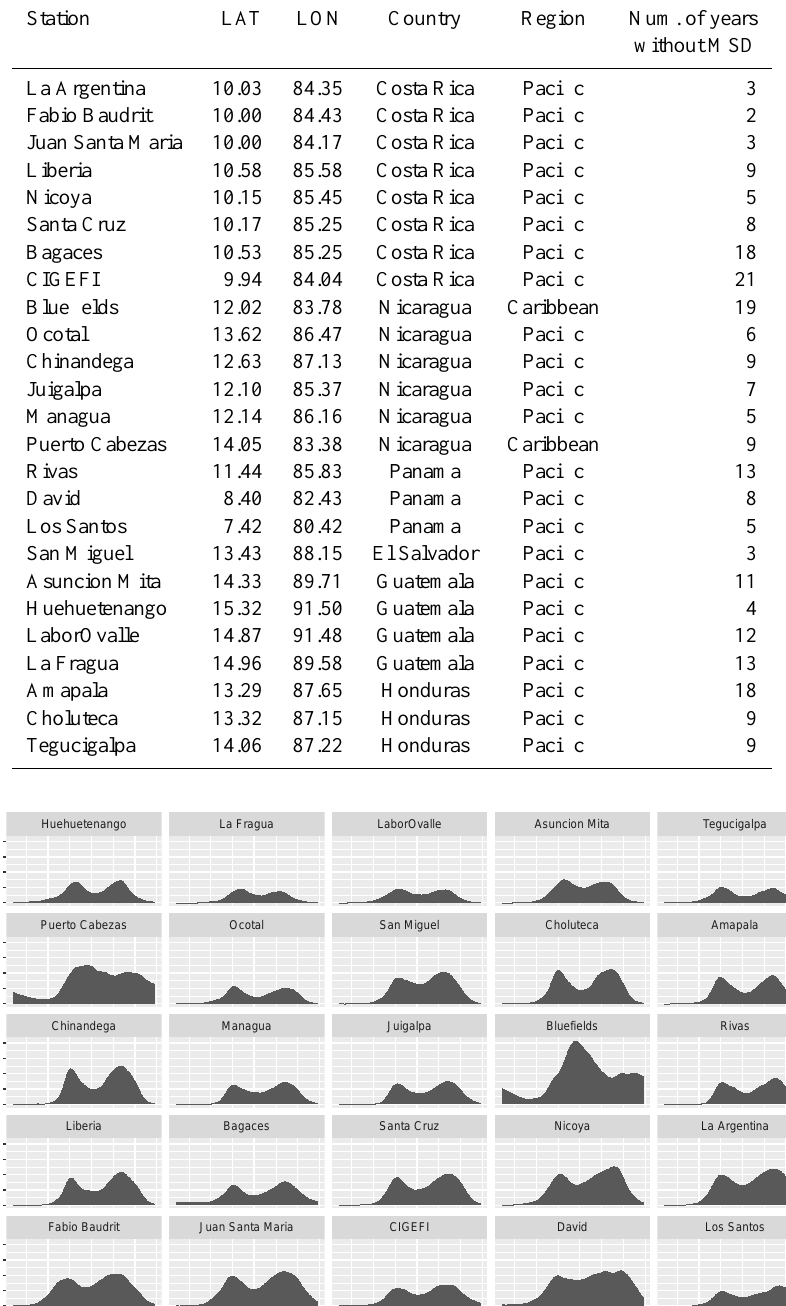
Table 1. Geographical position of the gauge stations in degrees north for latitude and degrees west for longitude. Station